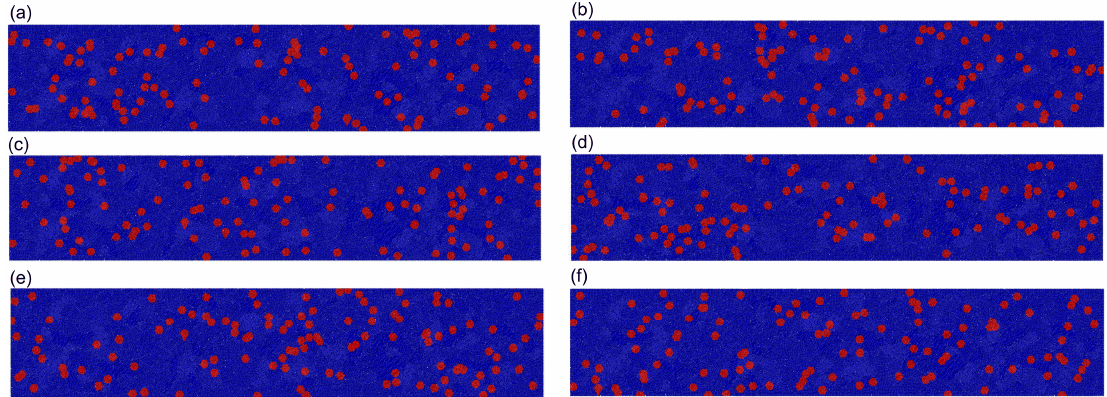
Figure A1. Six different random distributions of diamond in segment.